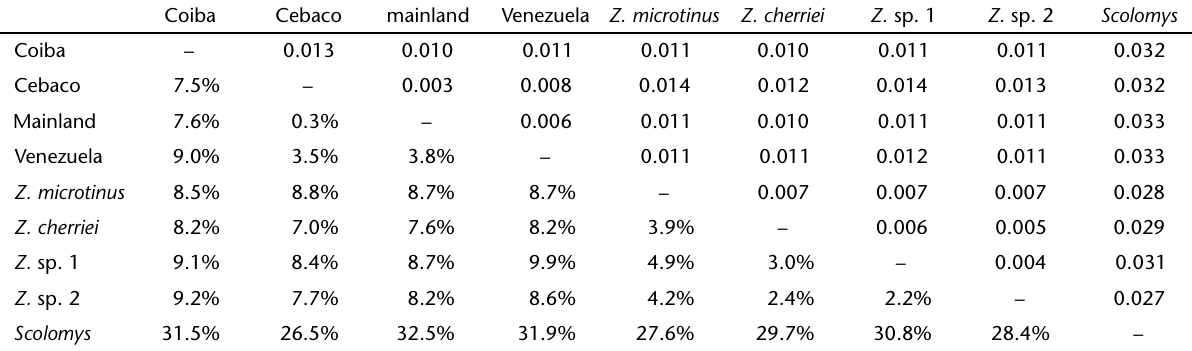
Table I. Distance matrix based on K2P values. The lower matrix represents the net between group average distances. The upper matrix represents the associated p-value. Zygodontomys sp. 1 and Zygodontomys sp. 2 correspond to two new species suggested by B ONVICINO et al.